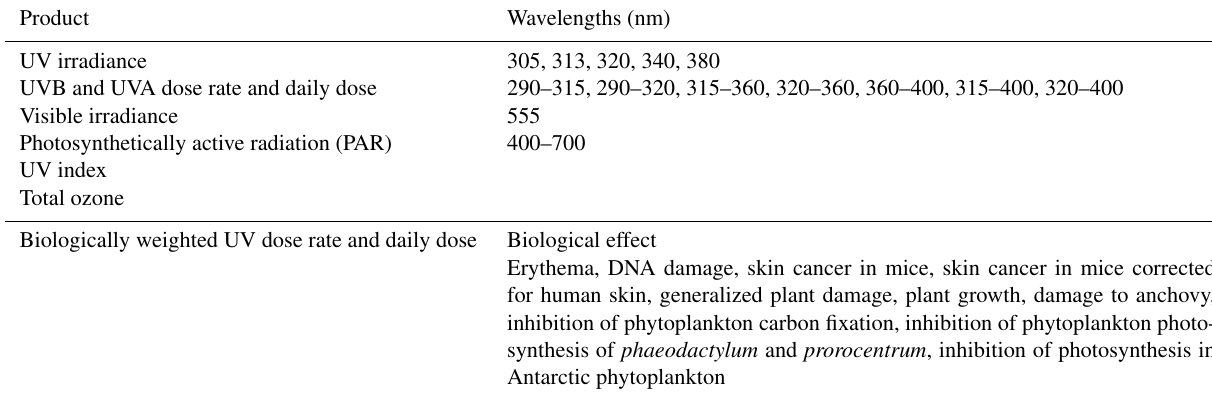
Table 2. Data products of the GUV radiometer at Marambio. Product